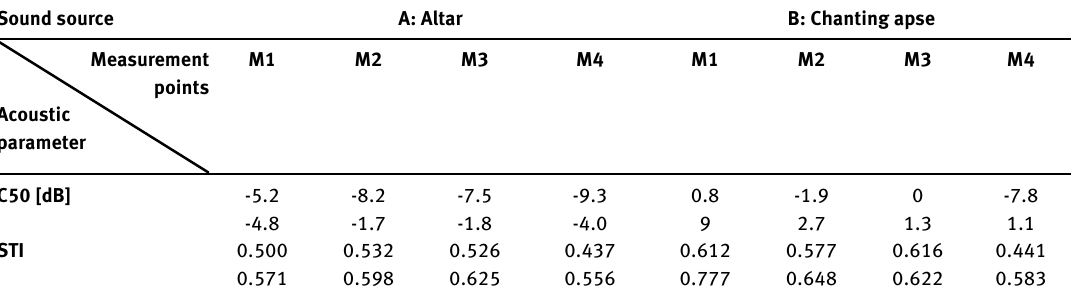
Table 3. Acoustic parameters for Ljubostinja and Naupara monastic